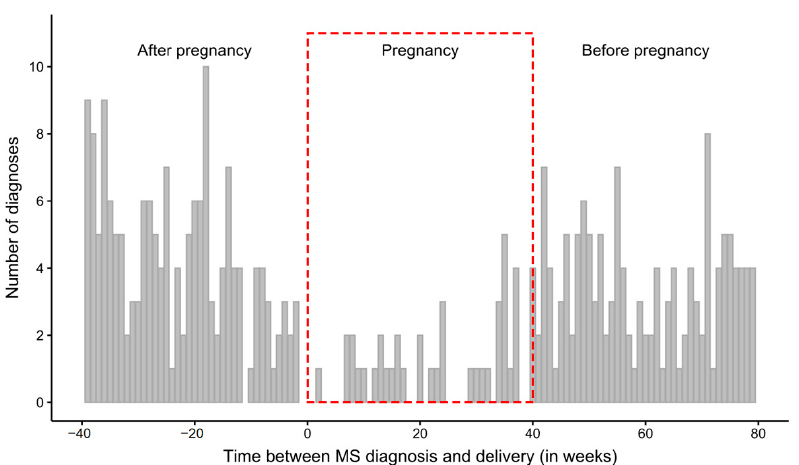
Figure 2. Distribution of time intervals between the first MS diagnosis and delivery. The observation window covers 40 weeks before pregnancy, during pregnancy (marked with a red frame) and 40 weeks postpartum. Positive interval (right side of the chart) values indicate that the first MS diagnosis occurred before delivery, while negative ones (left side of the chart) indicate that delivery occurred before the first MS diagnosis. The time interval between 0 and approximately 40 indicates that the first MS diagnosis occurred during pregnancy.